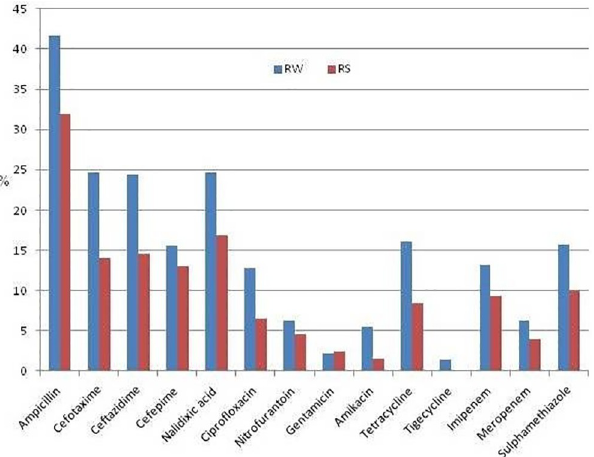
Fig 2. Percentage of antibiotic resistance detected in E . coli isolated from river-water (RW) and river-sediment (RS) collected during eight mass bathing events during 2014–2016 from river-Kshipra, Central India.